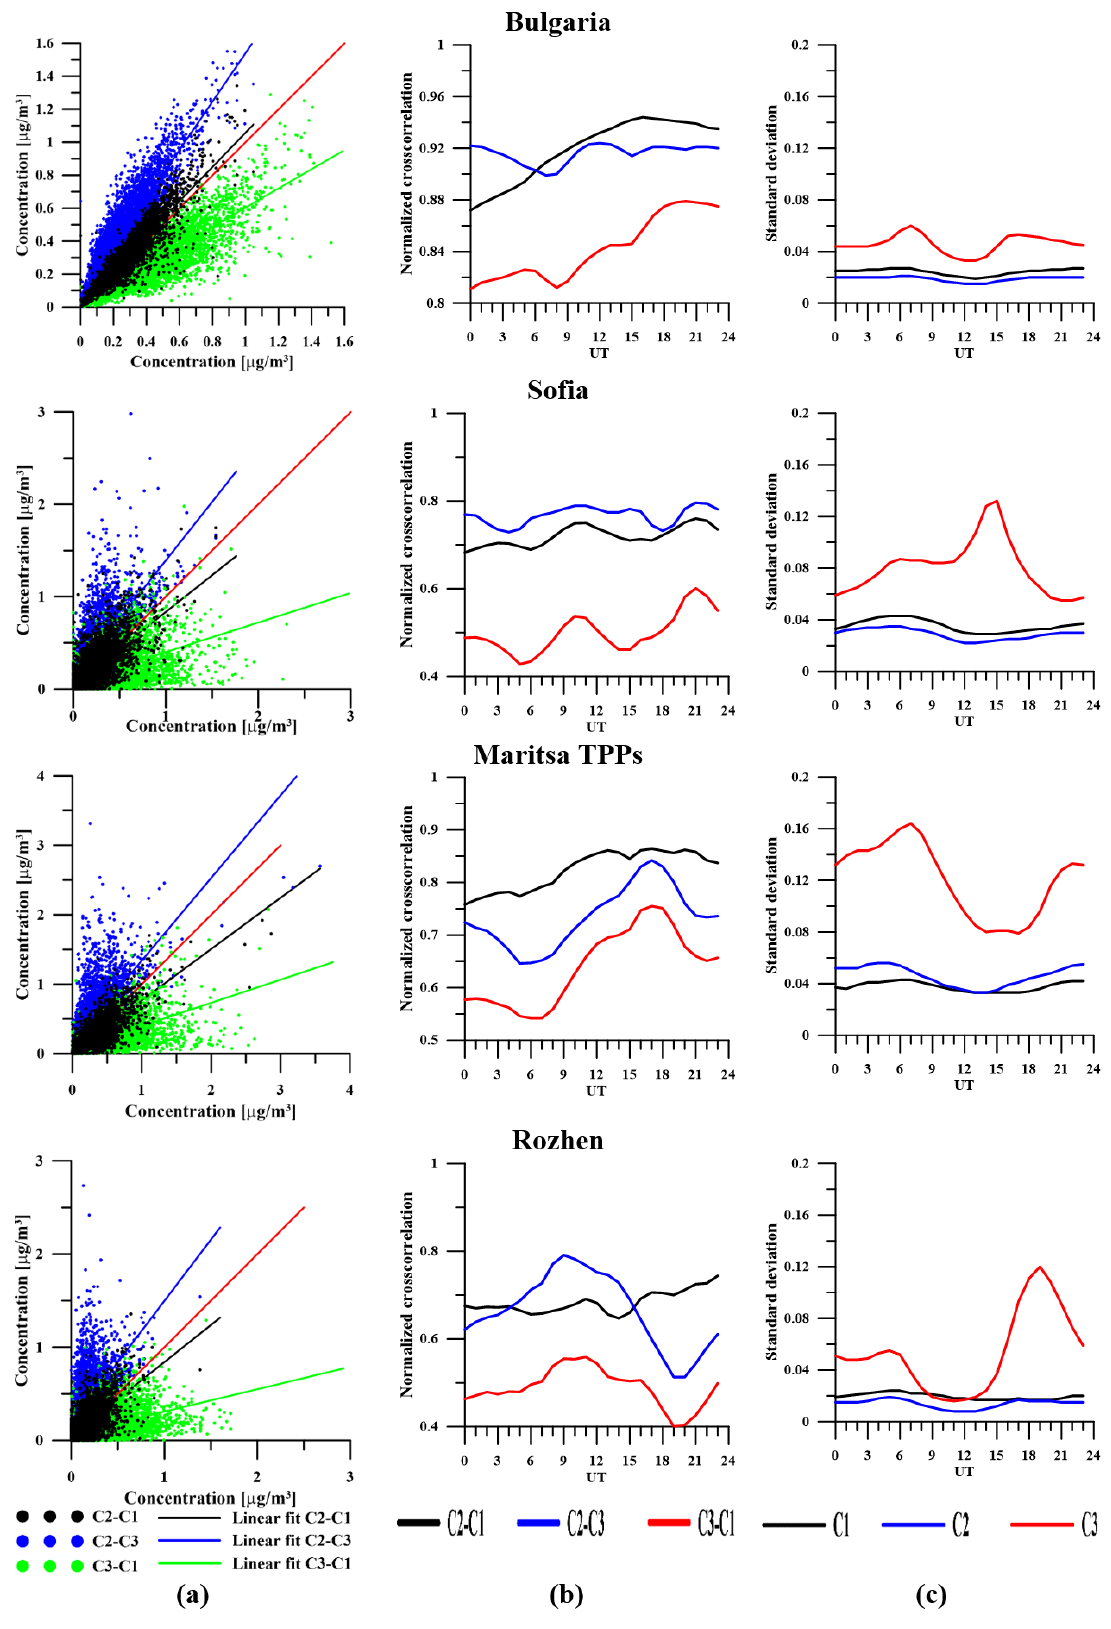
Figure 12. Comparisons of the regression ( a ) and correlations ( b ) and standard deviation ( c ) for PM 2.5 for the three cases.